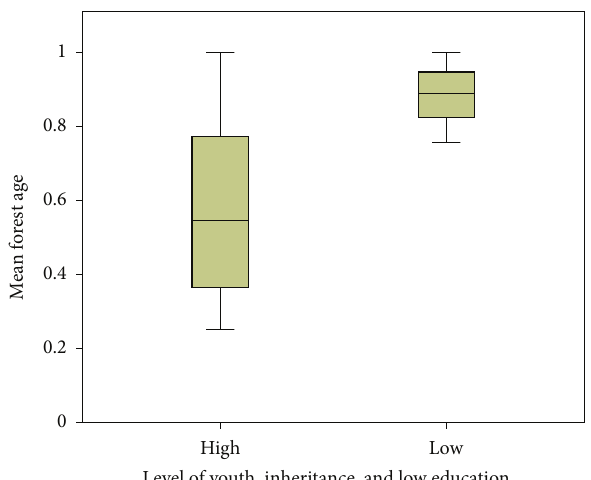
Figure 4: Landscapes with younger and lower educated small- holders who inherited their properties result in significantly lower average forest age at the landscape level.